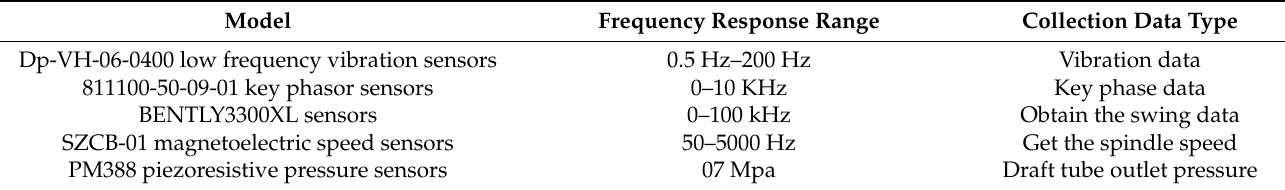
Figure 2. The structure of the bulb tubular hydropower units and the location of some sensors. Table 2. The main sensors used in the monitoring system. Table 1. Part of the original data of some of 107 measuring parameters on 9 October 2015.